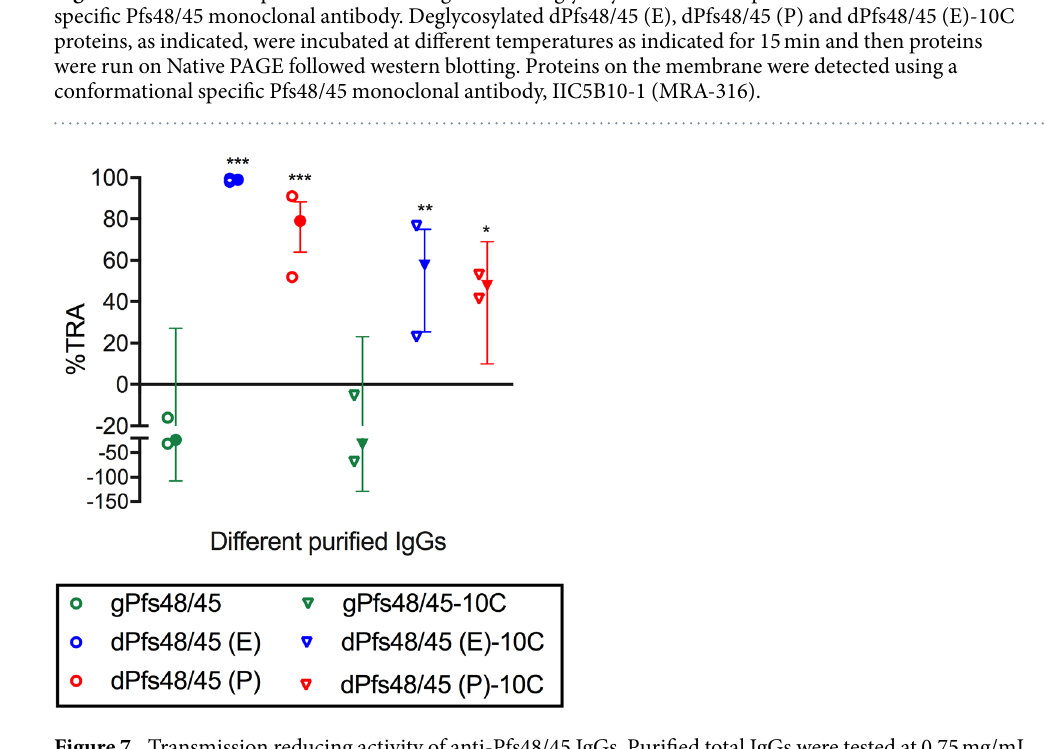
Figure 7. Transmission reducing activity of anti-Pfs48/45 IgGs. Purified total IgGs were tested at 0.75 mg/mL with complement in two independent assays. Individual feeding data (open symbols), and the best estimate (closed symbols) with 95% confidence intervals (bars) of % inhibition (%TRA) from the two feeds are shown. Significant inhibitions are indicated with asterisks: *** p < 0.001; ** p < 0.01; * p <